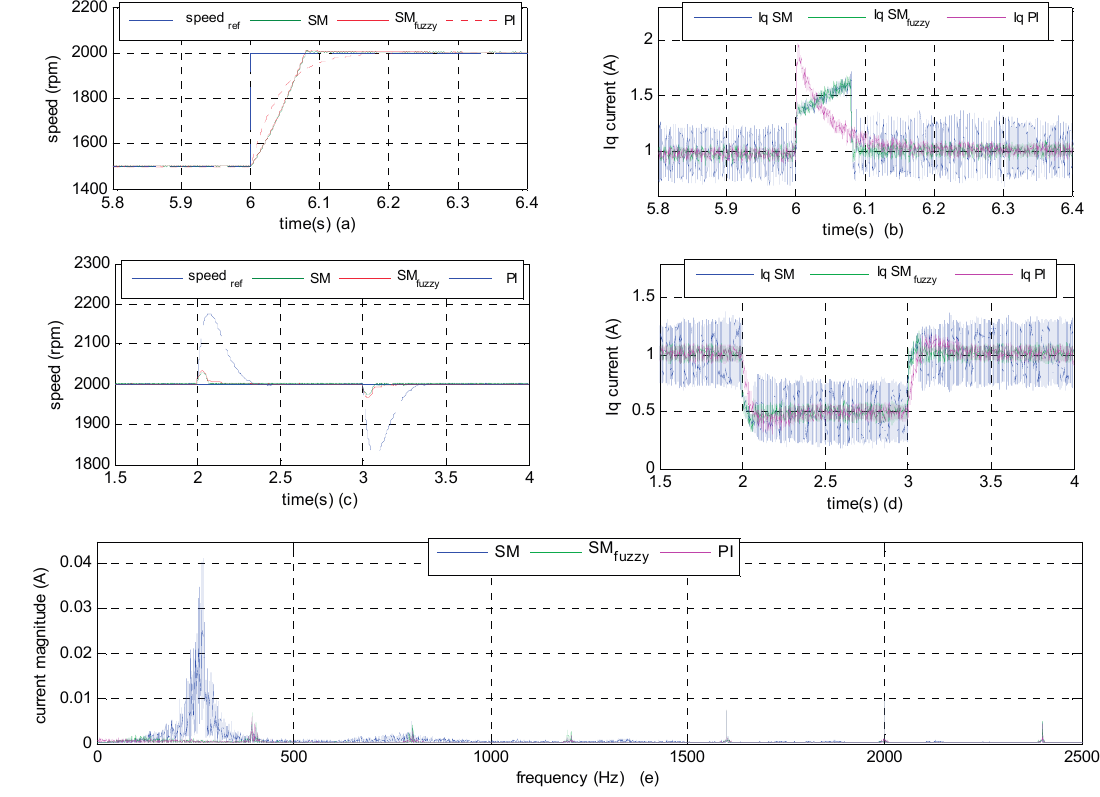
Figure 6. Simulation results. ( a ) Speed and ( b ) current following a reference speed change; ( c ) Speed and ( d ) current in presence of load disturbance; ( e ) Frequency analyses of quadratic current. This simulation was performed with SMC, Fuzzy-SMC and PI